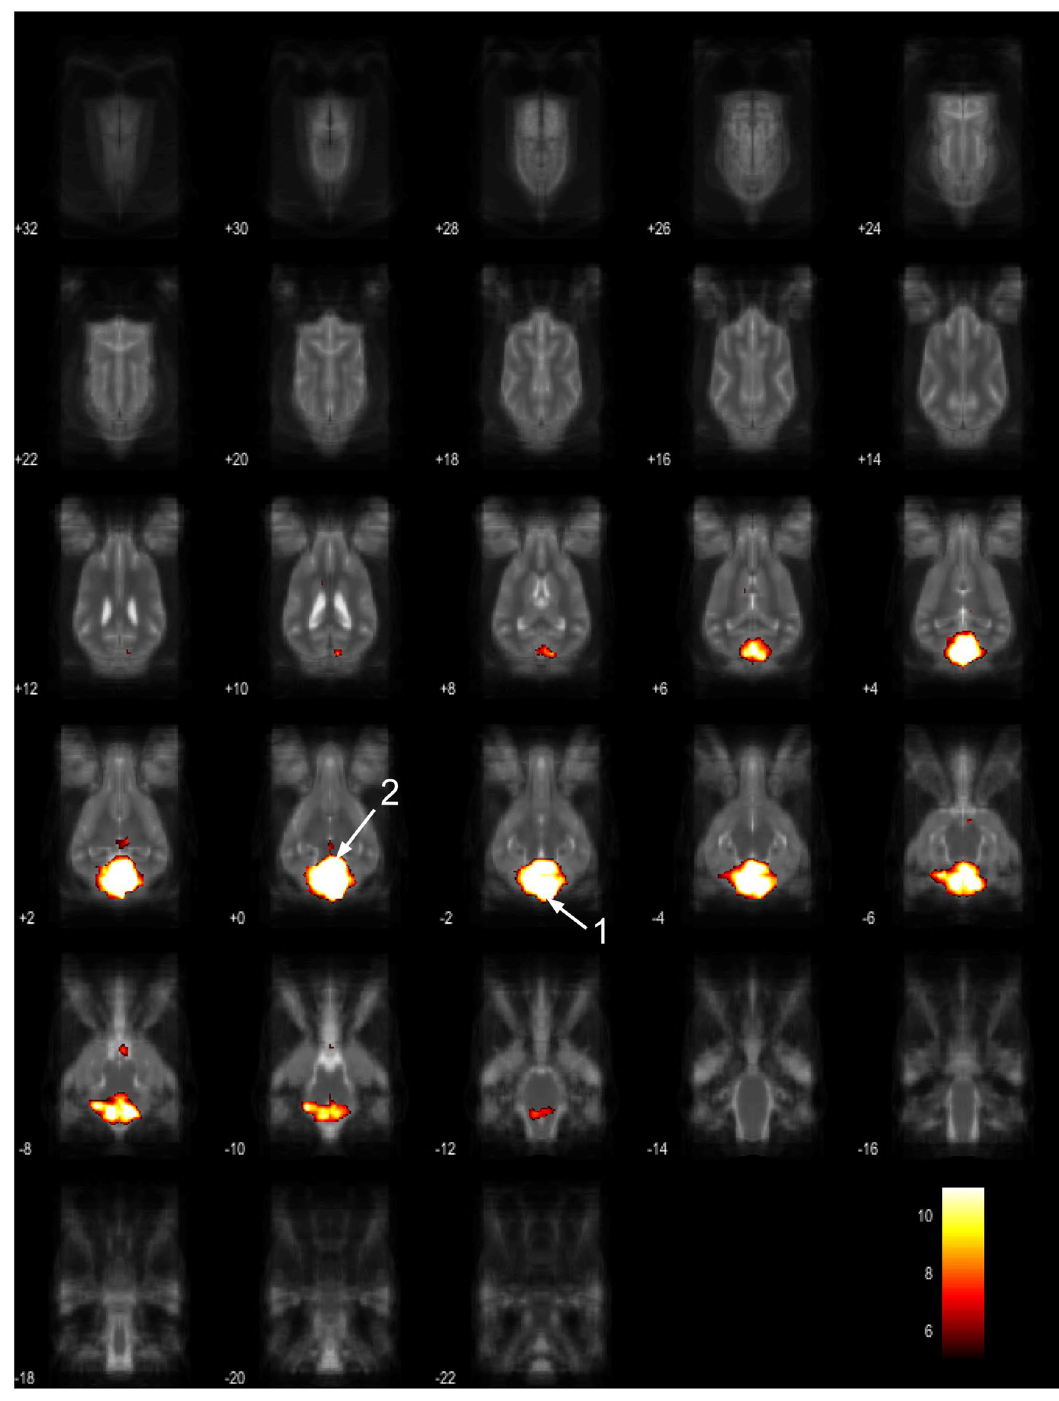
Figure 10. Resting-state network component G from the 15 component gICA. We report the results with a voxel-wise FDR corrected p < 0.001 and cluster treshold of FDR corrected p < 0.005. gICA components are presented as thresholded T-maps, corrected for multiple comparisons, overlaid on the Nitzsche atlas 15 . 1. cerebellum, 2. corpora